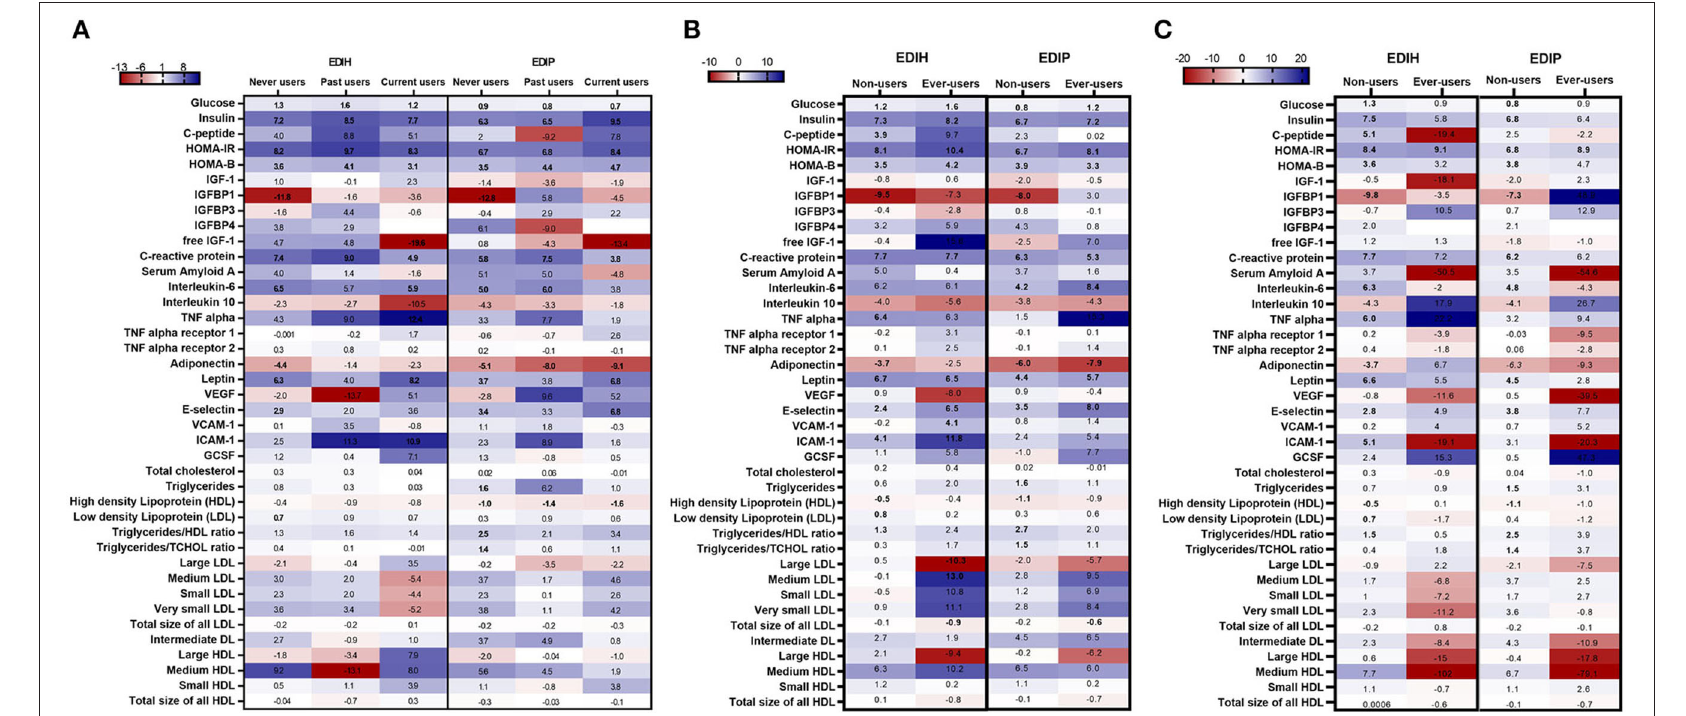
FIGURE 7 | Heat map showing the percentage difference (PD) in biomarker concentrations for each 1 standard deviation increment in the dietary index score in subgroups defined by (A) estrogen usage status, (B) NSAIDs use and (C) statin use. Biomarker concentrations were log transformed using natural logs. Values (beta coefficients) presented were obtained via multivariable-adjusted linear regression models adjusted for the following variables: total energy intake, BMI-continuous, age, total recreational physical activity, pack years of smoking; number of supplements used; fasting status at blood draw, race/ethnic groups, educational levels, regular use of NSAID, statins, unopposed estrogen and/or estrogen plus progesterone hormones, hormone therapy (HT) study arms, except when the covariate was the potential effect modifier. The color gradient ranges from red (inverse associations) to blue (positive associations). Values in bold font were statistically significant (FDR p <